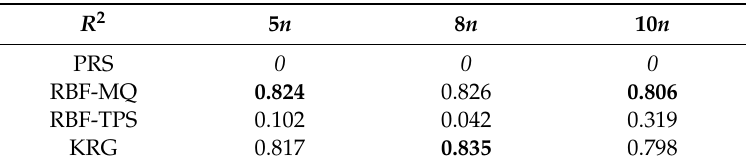
Table 11. Results of R 2 of four surrogate